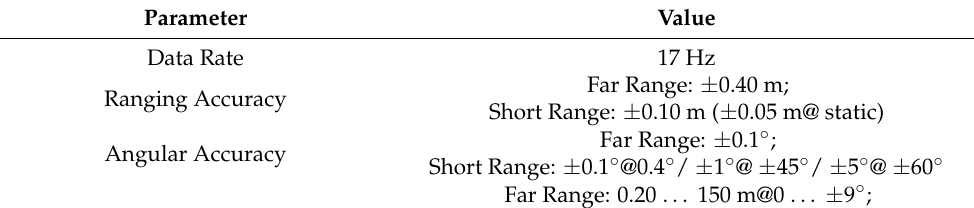
Table 1. 77 GHz Millimeter Wave Radar parameters.